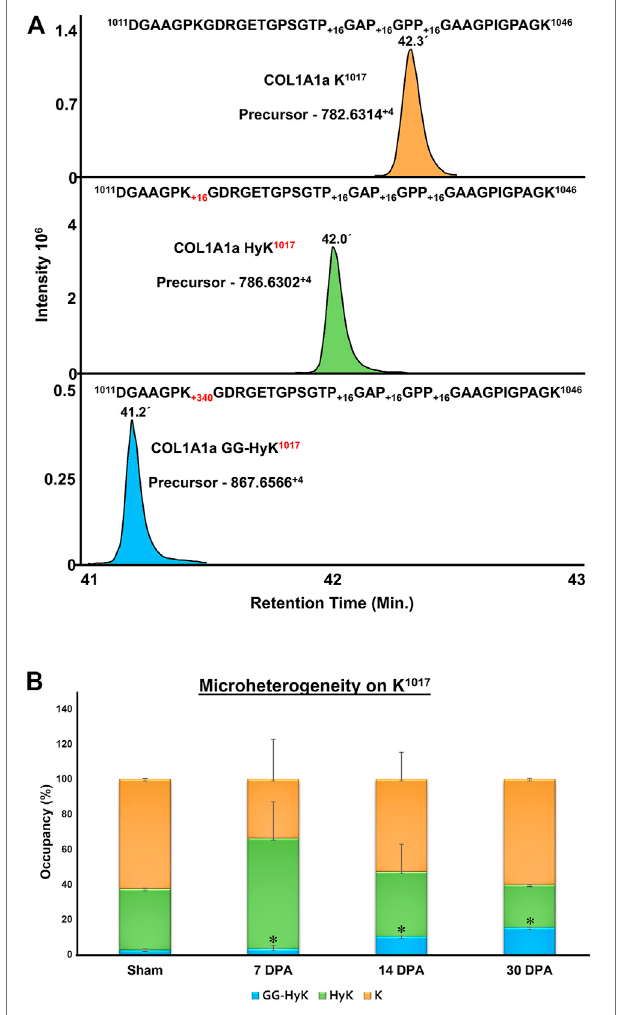
FIGURE 8 | Quantitation of microheterogeneity of K 1017 site in COL1A1a present in zebra fi sh heart ECM during regeneration. (A) Chromatogram plots represent the elution of unmodi fi ed (K) , hydroxylysine (HyK), and glucosylgalactosyl-hydroxylysine (GG-HyK) modi fi ed K 1017 site containing peptide 1011 DGAAGP K GDRGETGPSGTPGAPGPPGAAGPIGPAGK 1046 (B) Graphical representation of Skyline-based MS 1 quantitation of micro- heterogenic distribution of unmodi fi ed K 1017 (yellow), HyK 1017 (green) and GG- HyK277 (blue) species in COL1A1a from the ECM digest of control, 7 DPA, 14 DPA, and 30 DPA regenerating zebra fi sh heart. The different colors in the bar represent the occupancy of different forms at the K 1017 site in COL1A1a with mean ± SEM. An increase in glucosylgalactosyl-hydroxylysine levels during regeneration is signi fi cant (ANOVA, p < 0.05) (See Table 3